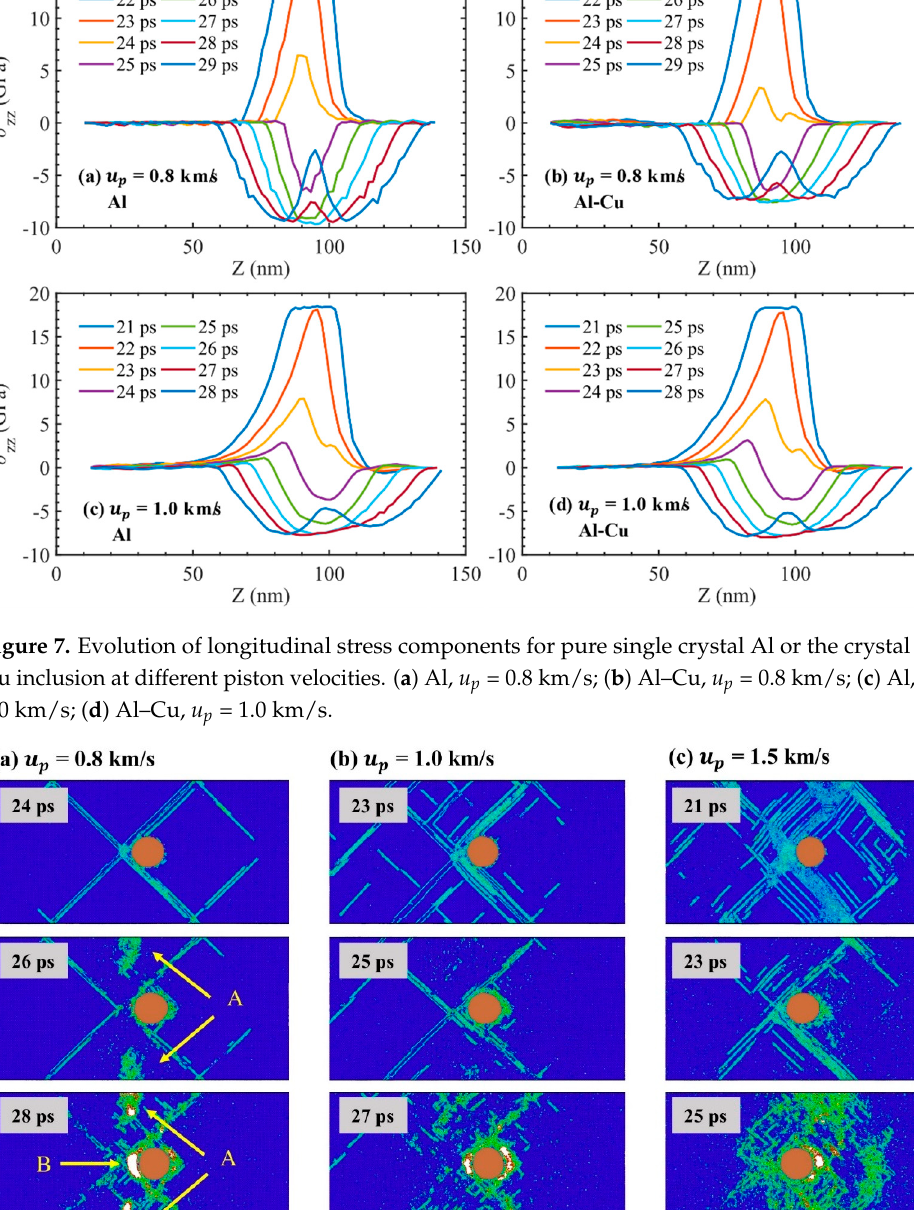
Figure 9. Spatial distributions of longitudinal stress components and atomic potential energy in the Al matrix in the central section of the system, u p = 0.8 km/s, t = 26 ps. Regions A and B here correspond to regions A and B in Figure 8a.